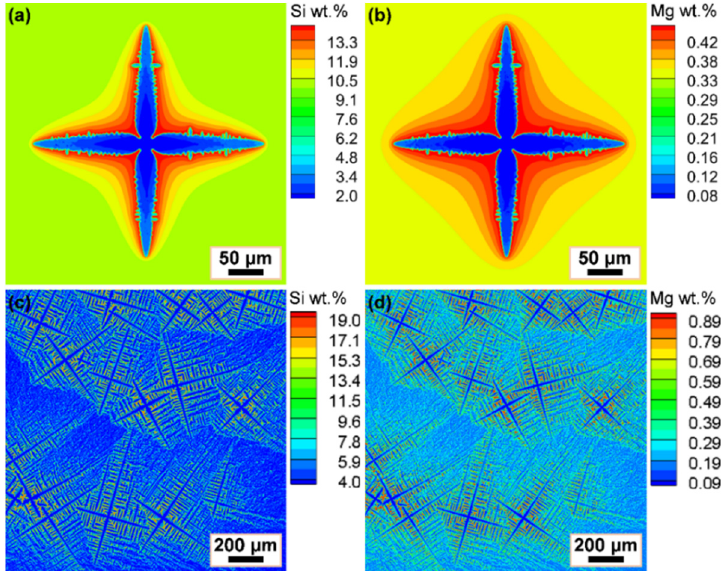
Figure 4. Simulated solute distribution and single/multiequiaxed dendritic morphologies of AlSi10Mg alloy: ( a , c ) Si solute concentration fields; ( b , d ) Mg solute concentration fields.